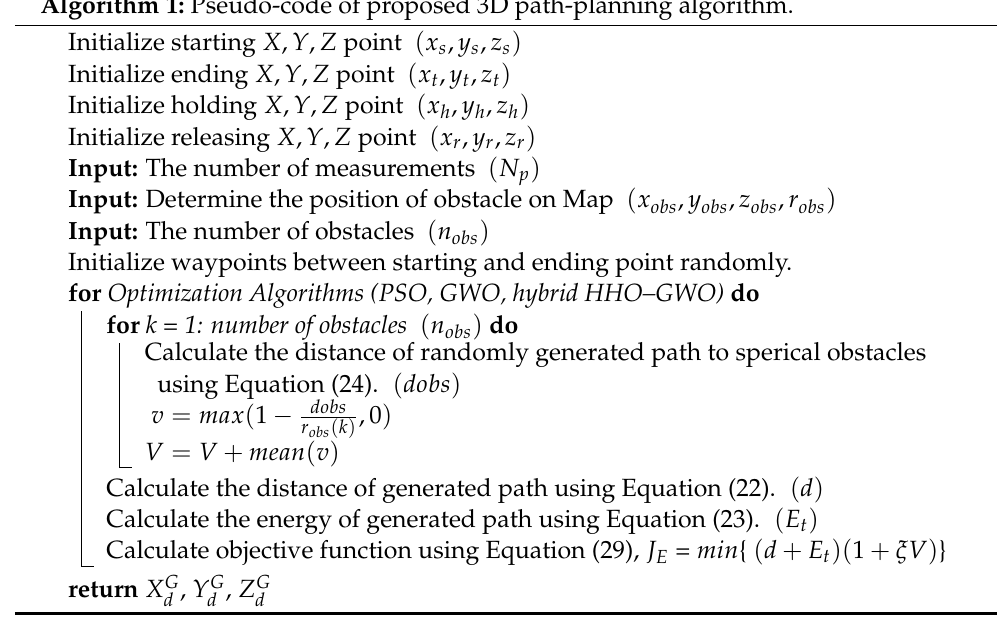
Algorithm 1: Pseudo-code of proposed 3D path-planning